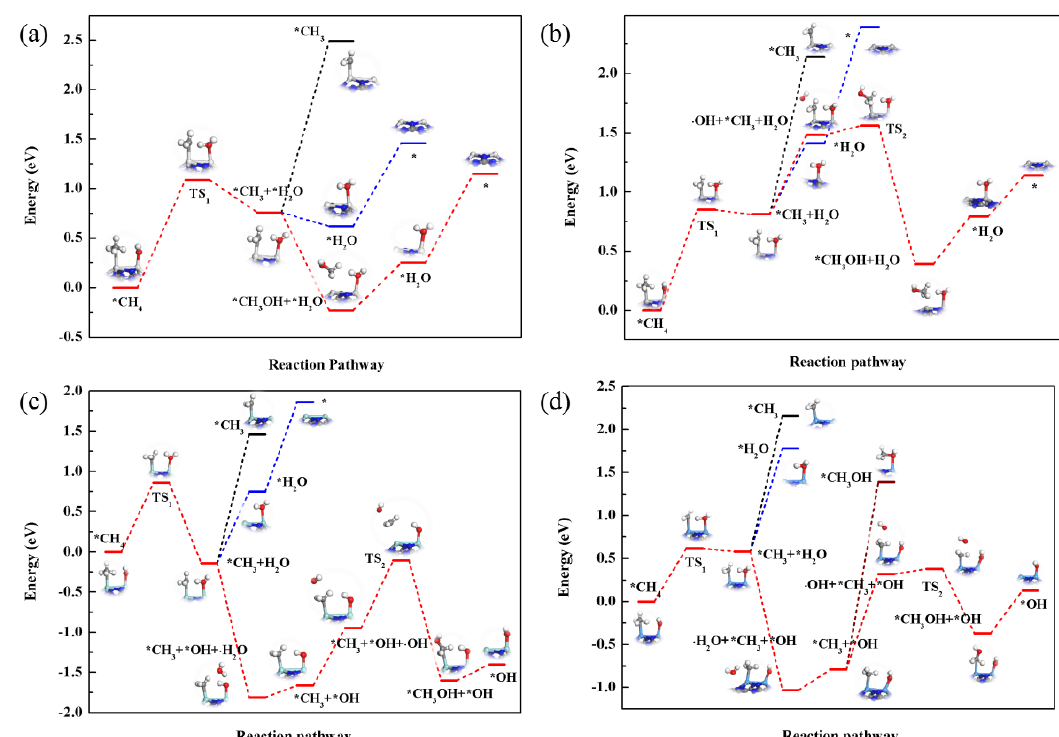
Figure 2. Reaction pathway of *OH-assisted CH 4 decomposition on the Sc 2 -Pc ( a ), Ti 2 -Pc ( b ), Zr 2 -Pc ( c ), and Ta 2 -Pc ( d ) monolayers. Blue, black, and red lines represent the reaction paths for *CH 3 desorption, *H 2 O desorption, and the reaction with OH in the solution, respectively.